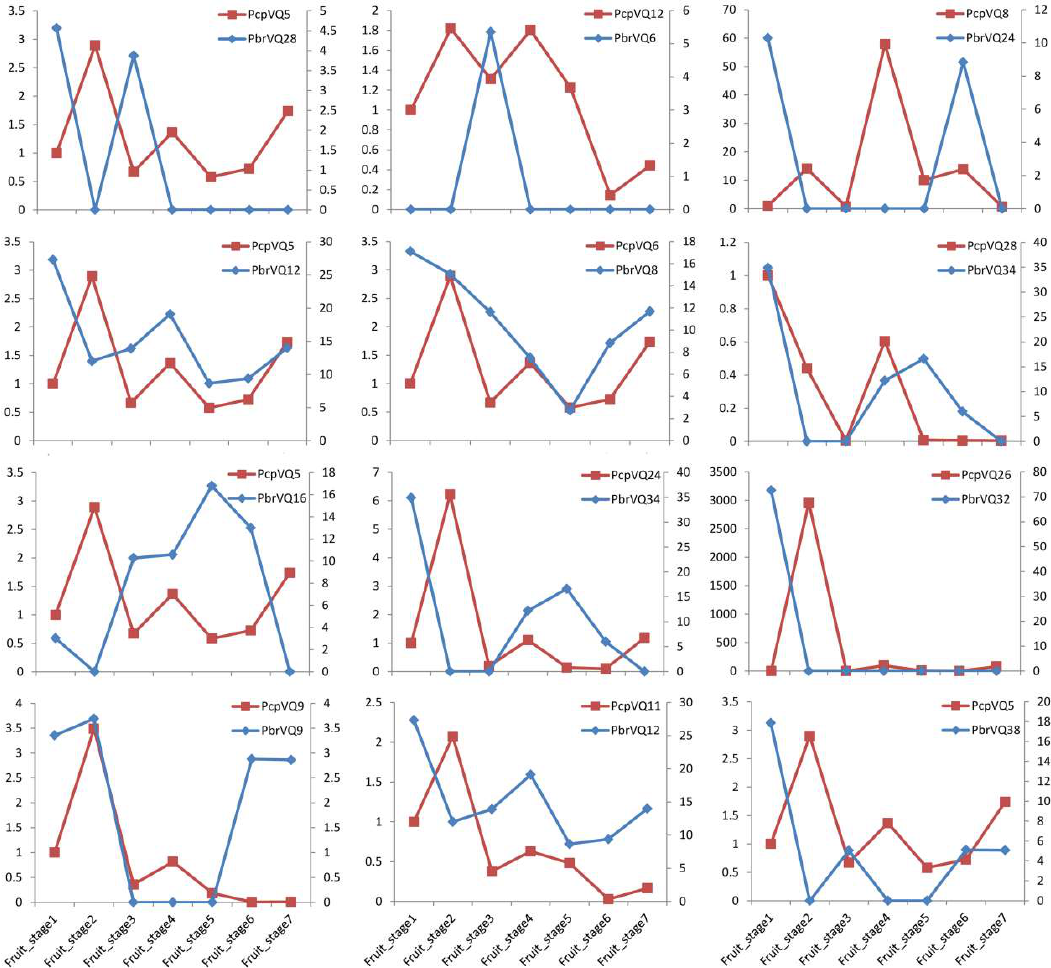
Figure 6. Comparison of the expression patterns of P. bretschneideri VQ motif-containing genes and their orthologous in P. communis during fruit development. X-axis represents the fruit developmental stages. Y-axis on the left indicates the relative values of FPKM in P. bretschneideri VQ motif-containing genes by blue line charts, and Y-axis on the right represents the relative gene expression levels of qRT-PCR in P. communis by red line charts. The FPKM values of PbVQ genes are presented in Table S5.